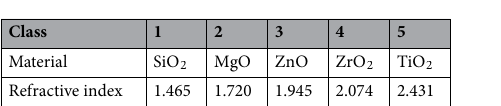
Table 1. Different materials, associated classes and refractive